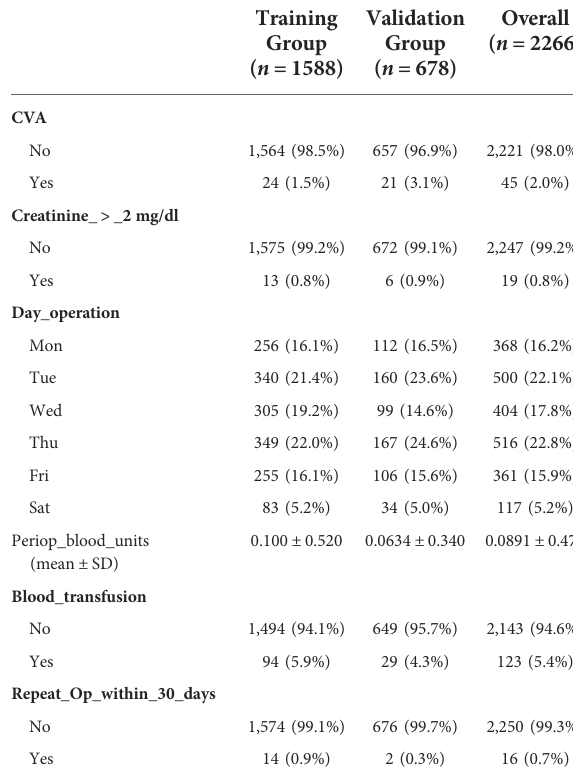
TABLE 2 Clinical characteristics of patients who underwent TKA in training and veri fi cation